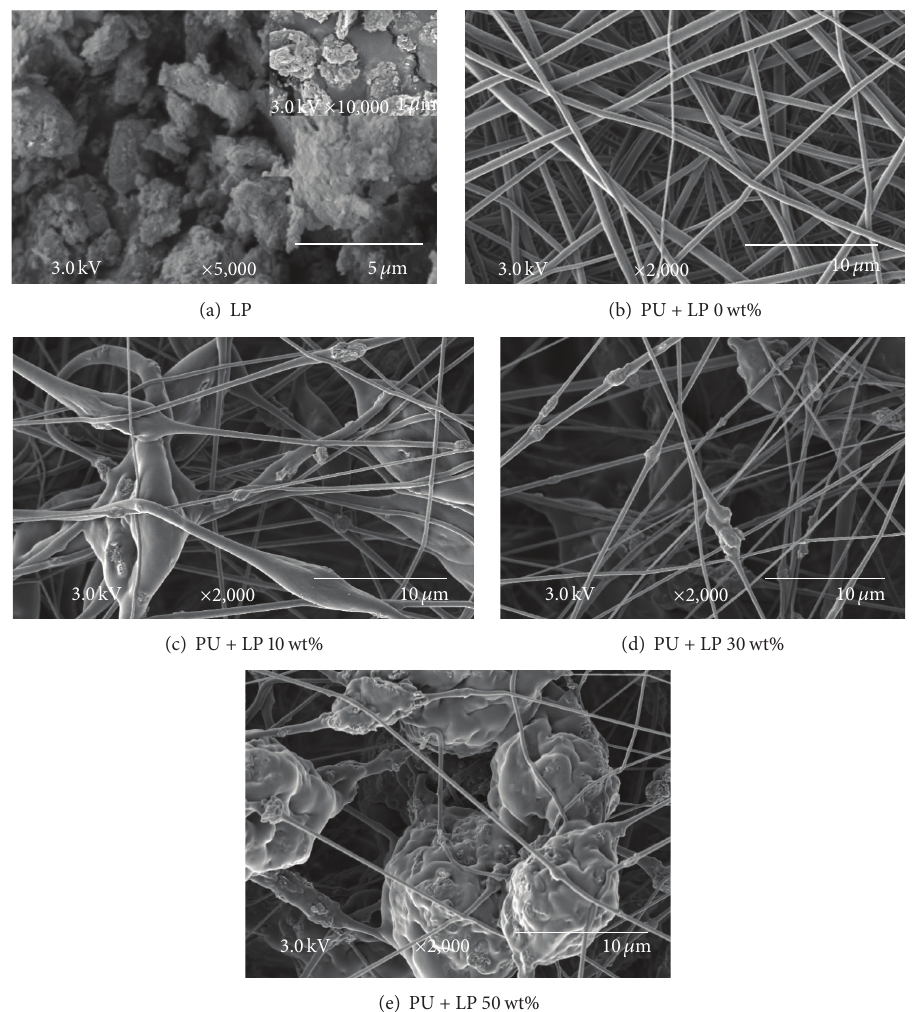
Figure 2: FE-SEM images of PU/LP electrospun fibers containing 0, 10, 30, and 50 wt%